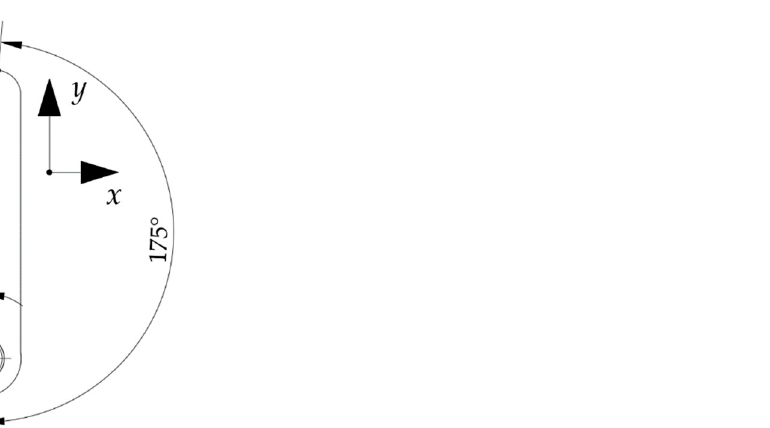
Figure 14. Illustrated definition of the length d for the purpose of determining the moment of inertia of the cam, as well as two extreme position points of the cam during its rotation c (initial point) and c’ (final point).